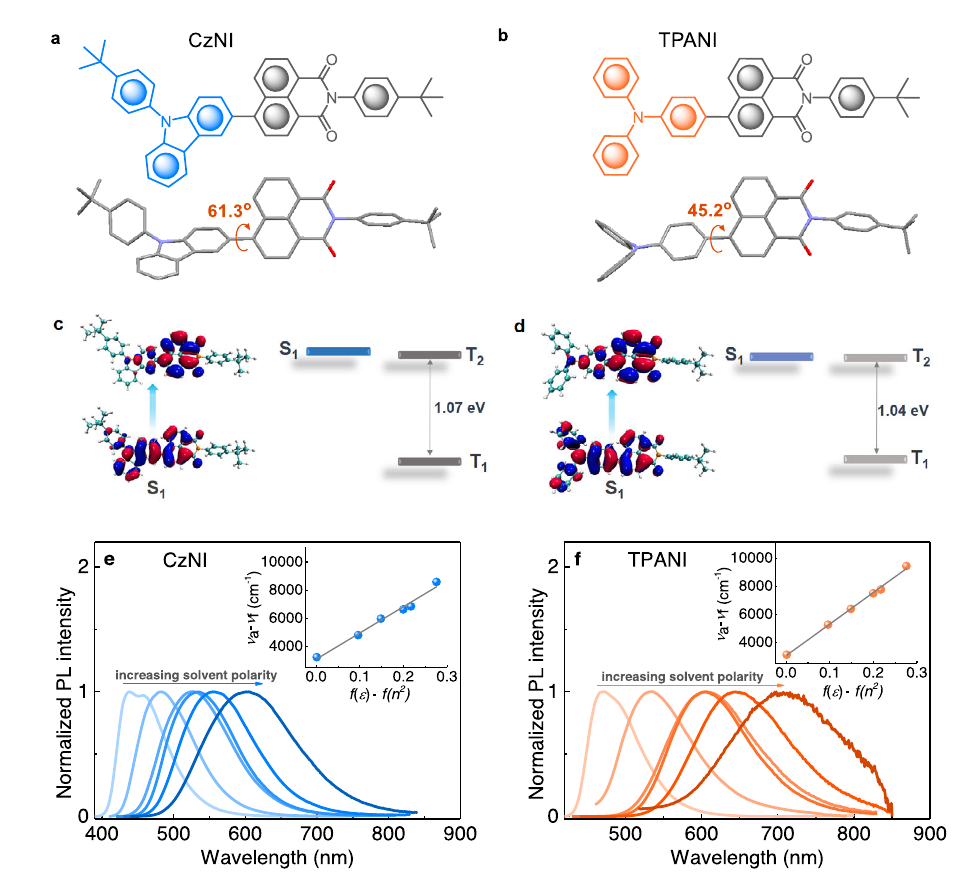
Fig. 2 | Molecular structures, theoretical calculation results and PL spectra. Molecular structures and single crystal structures of a CzNI and b TPANI. The natural transition orbital (NTO) pairs and energy levels of c CzNI and d TPANI for the representative excited states of S 1 , T 1 , and T 2 . Normalized PL spectra of e CzNI and f TPANIinsolventswithdifferentpolarity(10 − 5 M,solventsusedwithincreasing